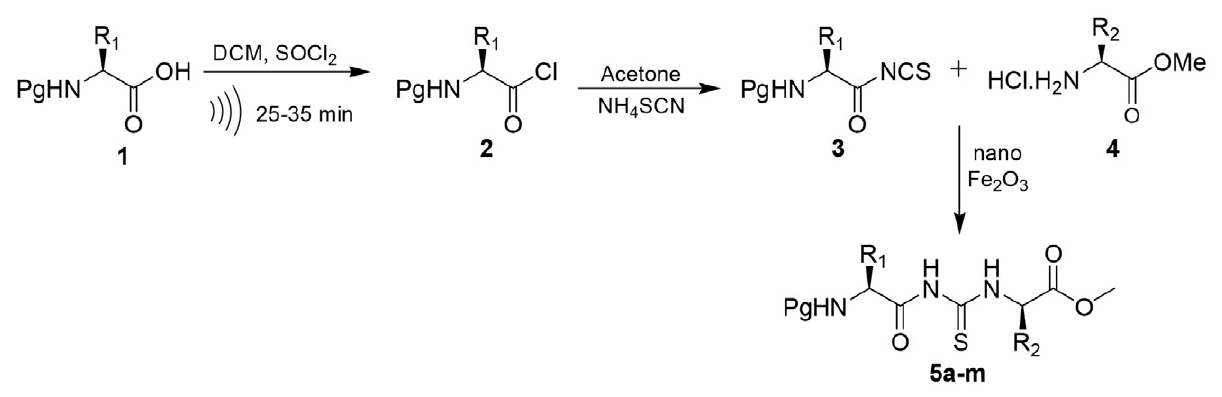
R 1 , R 2 : H, alkyl, aryl groups Pg (Protecting group): Fmoc (fluorenylmethyloxycarbonyl), Cbz